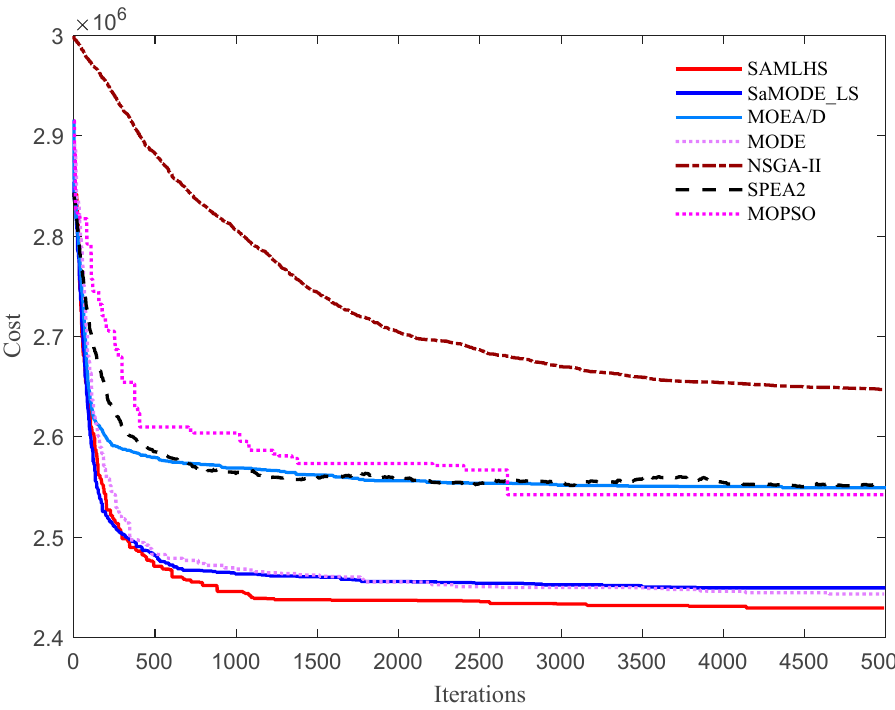
Figure 2. The convergence of cost for different algorithms.